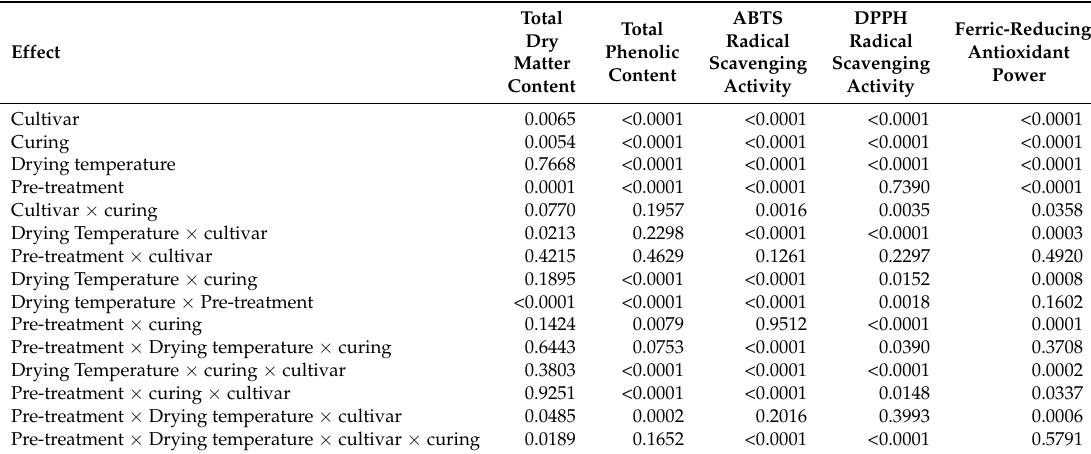
Table 2. Analysis of variance (ANOVA) of results of total dry matter content, total phenolic content, ABTS radical scavenging activity, DPPH radical scavenging activity, and ferric-reducing antioxidant power as a function of the process variables of the yacon chips.